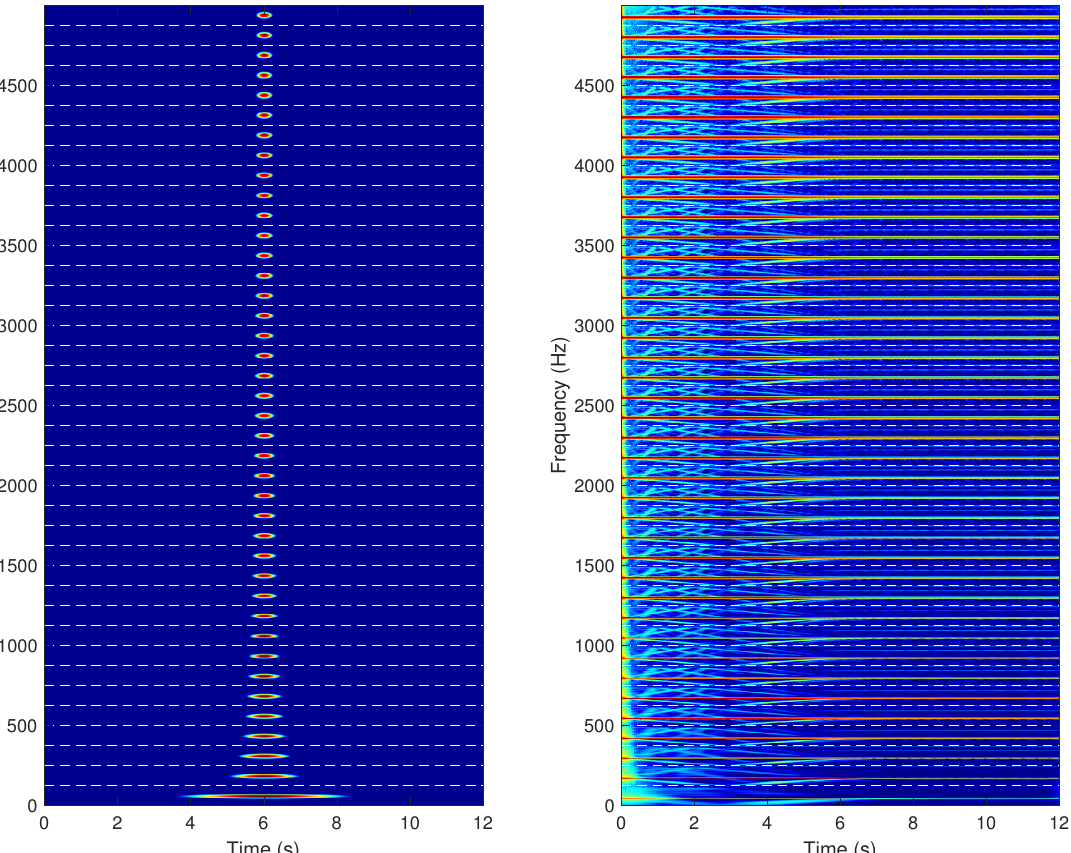
Figure 10. Spectrograms of the current of Figure 8 ( right ) obtained with the multi-band window (21) ( left ). The 40 stacked spectrograms have been obtained with a single run of the short-time Fourier transform (STFT) algorithm.